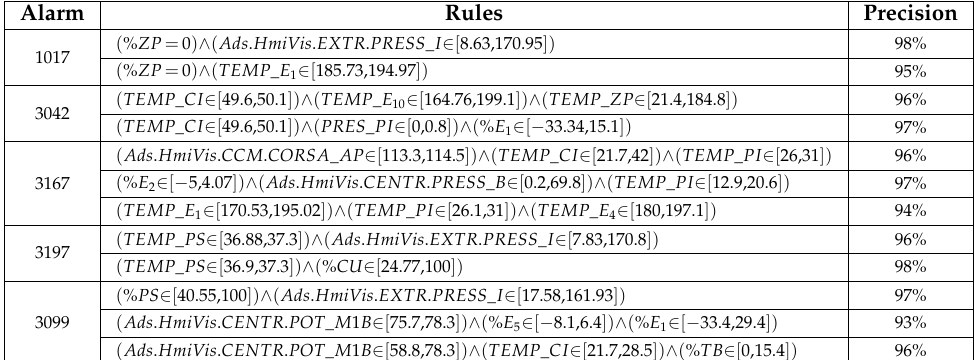
Table 1. Relaxed Separate-and-Conquer (RSC) (RUL = 0